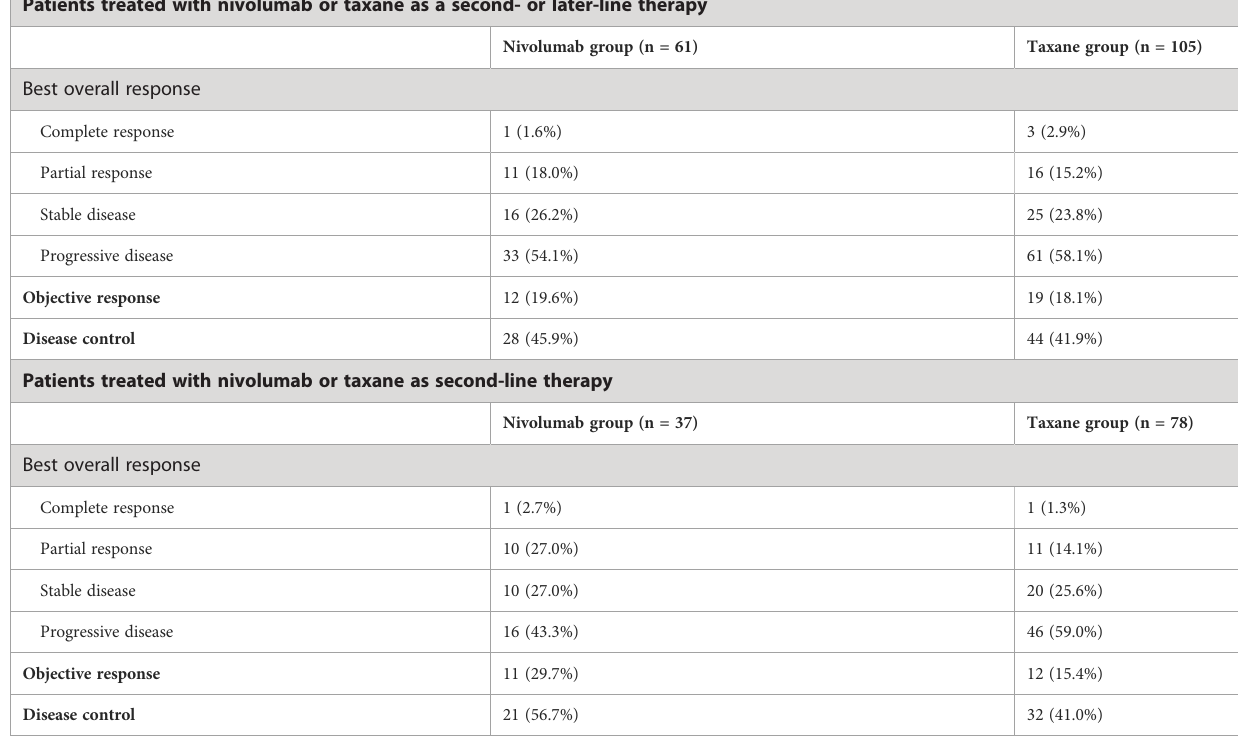
TABLE 2 Treatment response to nivolumab or taxane. Patients treated with nivolumab or taxane as a second- or later-line